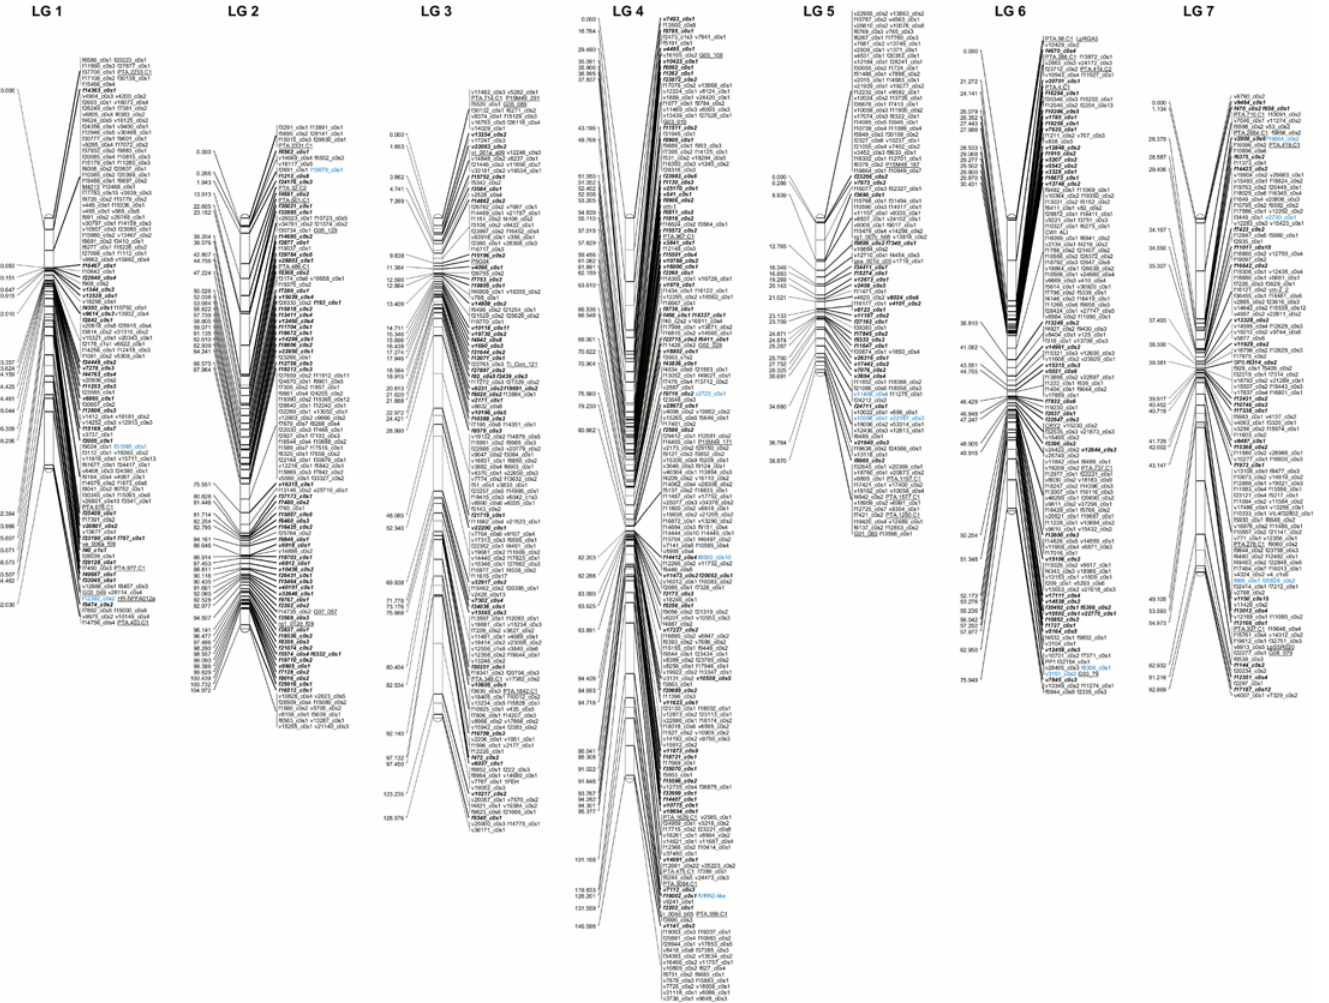
Fig 1. Perennial ryegrass genetic map consisting of candidate genes for vernalization and cold response. High confidence F2-type map presenting the F2 type markers (bold italics) based on which the QTL analysis was performed. The remaining markers are presented in bins. Markers underlined are common with the perennial ryegrass genetic map previously developed from a comprehensive Expressed Sequence Tag (EST) collection [31]. Markers presented in blue were positioned on the map based on co-location on the same genomic scaffold with a mapped